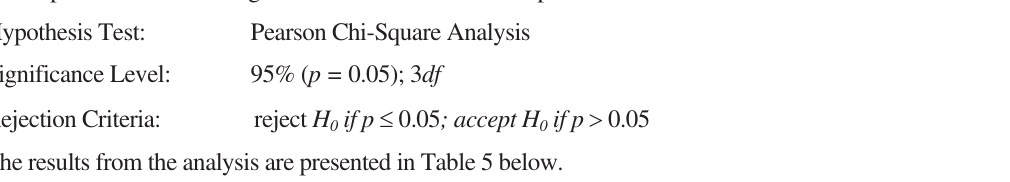
Table 5. Chi-square analysis – emotional intelligence and managerial level